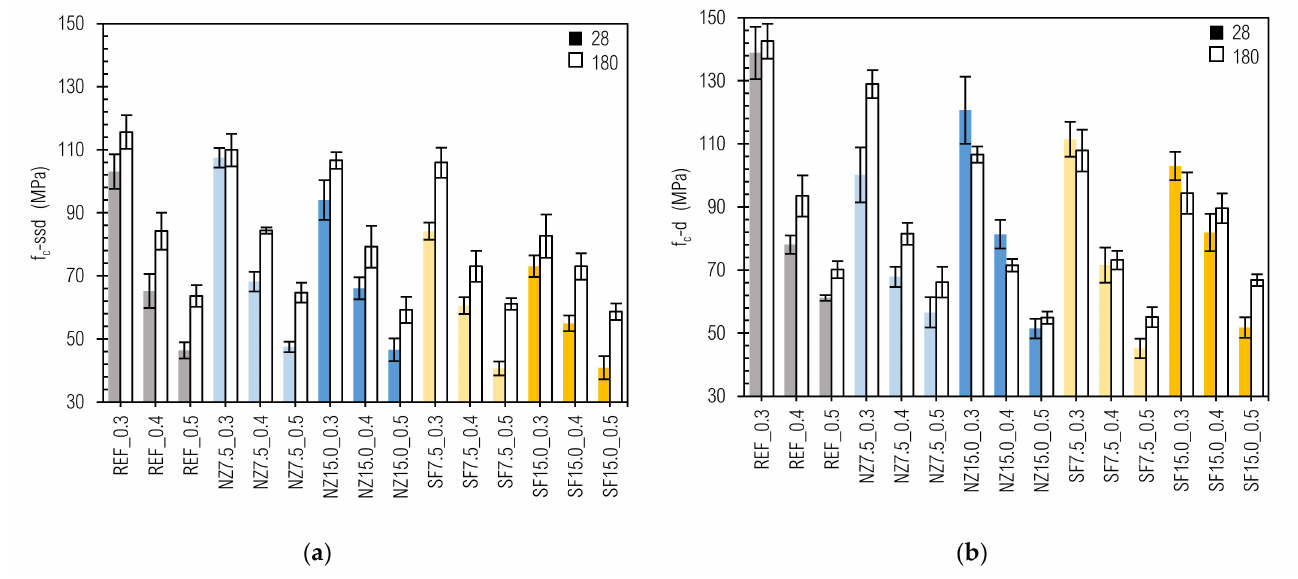
Figure 9. Compressive strengths: ( a ) ssd state; ( b ) oven-dried state. Mutual comparisons between particular results are given in Figure 10.